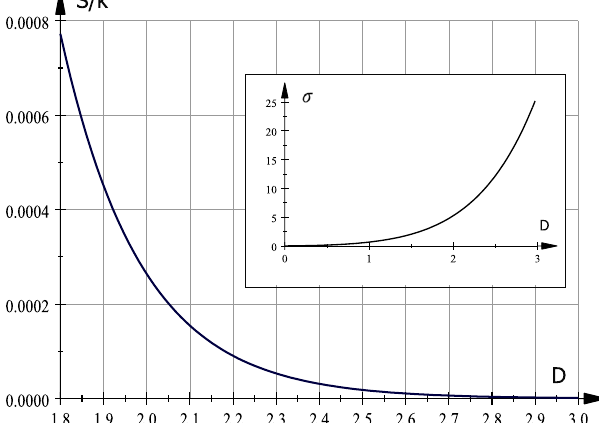
Figure 1. Entropy S / k , per particle, for direct and dual systems in graphene as function of dimension D at T = ± 300 °K. Inset, the parameter σ as function of spatial dimension D . It allows to evaluate thermodynamic properties around D = 2 where σ =